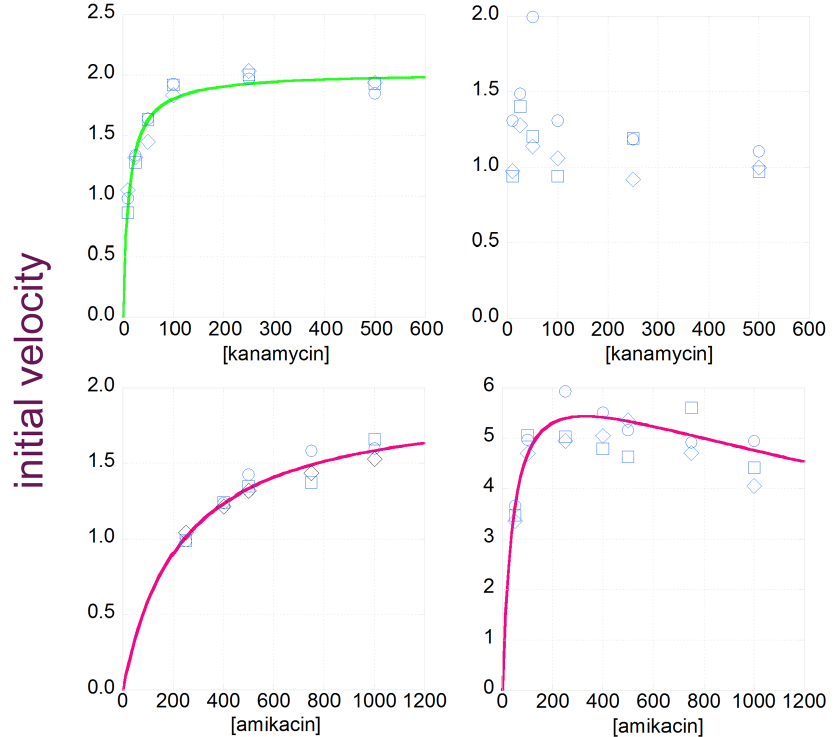
Figure 2. Michaelis-Menten plots of the wild-type and 4.1 APH(3 9 )-IIIa variants. The plots show the dependence of initial velocity upon substrate concentration for the following reactions: a) wild-type APH(3 9 )-IIIa with kanamycin, b) artificially evolved 4.1 variant with kanamycin, c) wild- type APH(3 9 )-IIIa with amikacin, and d) 4.1 variant with amikacin. Substrate concentration is in units of micromolar and reaction velocity is in moles of substrate/moles of enzyme/second. Each series of reactions was conducted in triplicate. The average initial velocity values were fit to the Michaelis- Menten equation (a, c) or a simple substrate inhibition model (d) as described in the Methods; the derived kinetic parameters are presented in Table 4.